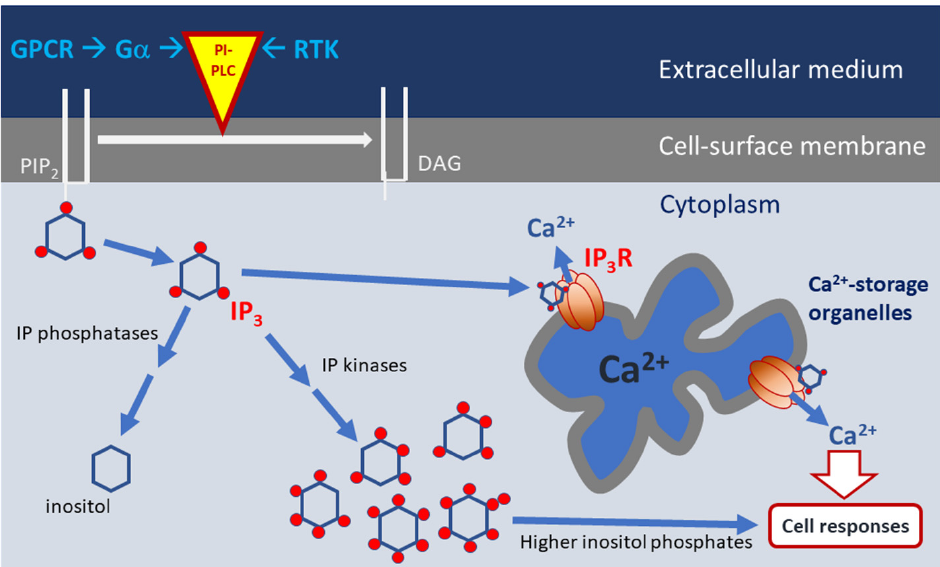
Figure 1. Generalized scheme of phosphoinositide signalling in eukaryotic cells. Extracellular signals ca interact with cell-surface receptors, such as 7-transmembrane G-protein coupled receptors (GPCRs) or receptor tyrosine kinases (RTKs). GPCRs are associated with heterotrimeric GTP-binding proteins. The Ga q/11 subunits of these dissociate from activated receptors to stimulate b-subtypes of phosphosphingolipids-specific phospholipase C (PI-PLC). Activated RTKs stimulate g-subtypes of PI-PLC, by phosphorylating specific tyrosine residues. PI-PLCs cleave the minor membrane lipid phosphatidyl 4,5-bisphosphate (PIP 2 ) to form soluble IP 3 and membrane associated DAG. IP 3 interacts with IP 3 Rs located in Ca 2+ -storage organelles such as the endoplasmic reticulum and vacuole, gating an intrinsic ion channel to release Ca 2+ into the cytoplasm. IP 3 can be inactivated by progressive dephosphorylation by inositol phosphate (IP) phosphatases, to generate inositol. This is recycled during the regeneration of PIP 2 . IP 3 is also phosphorylated by IP kinases to form higher IPs, which have diverse biological functions distinct from the Ca 2+ -releasing role of IP 3